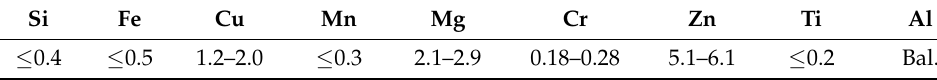
Table 1. Chemical composition of the 7075 aluminum alloy.